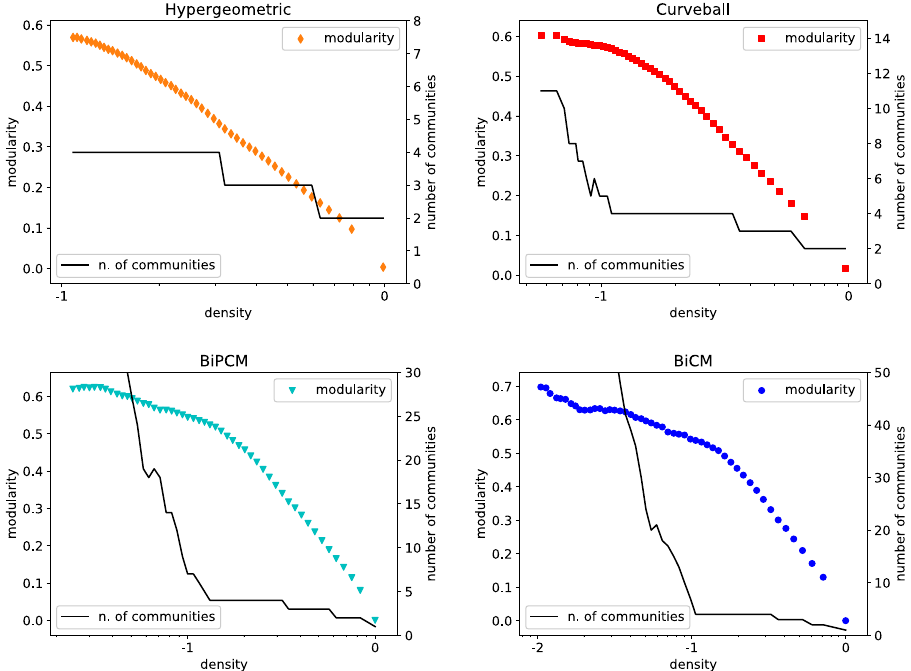
Fig. 6 Modularity and number of communities for the best partition obtained by the Louvain method on the validated network, as a function of the density ρ of validated links. Each point corresponds to the partition of highest modularity obtained in 100 runs of the algorithm with random initialization (hence it has no associated error). While modularity monotonically decreases with the density, we observe that the number of communities has a plateau at 4 for 0.1 ≲ ρ ≲ 0.3, suggesting the presence of a region where an agreement between the four approaches is recovered.